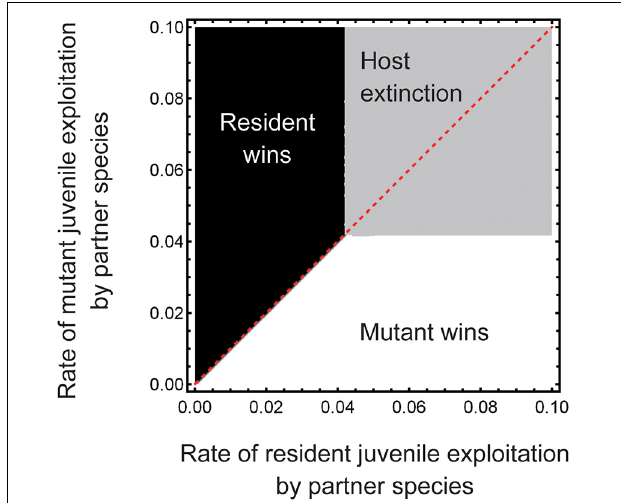
FIGURE 6 | Pairwise invasibility plots. The horizontal and vertical axes represent the rates of resident and mutant juvenile exploitation by the partner species, respectively. The white region indicates mutant dominance, whereas the black region indicates expulsion of the mutant by the resident. The gray region indicates extinction of the host species. The red dashed line indicates a one-to-one correspondence. The origin of the graph indicates the evolutionarily stable strategy where any mutants cannot invade the population, and thus, evolution does not occur. Other parameter values are the same as in Figure 3